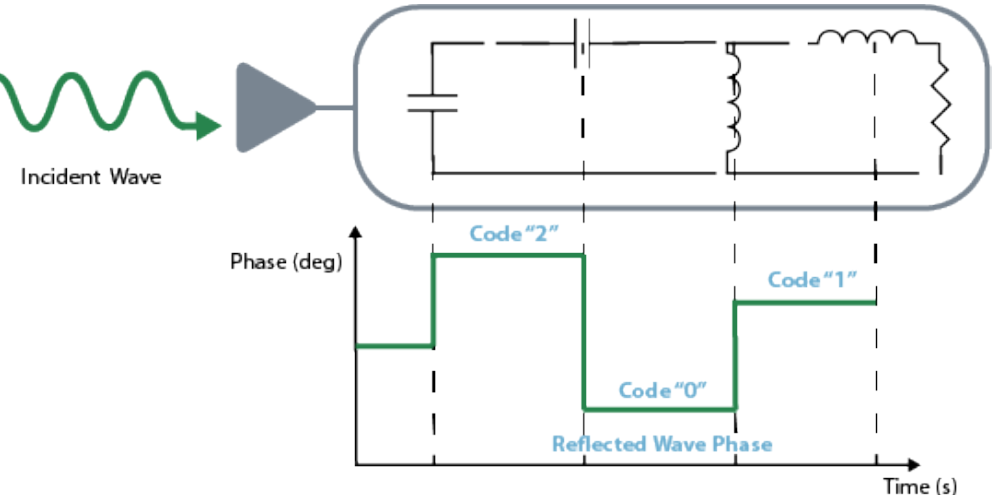
Figure 12. Encoding based on the phase modulation. Adapted from